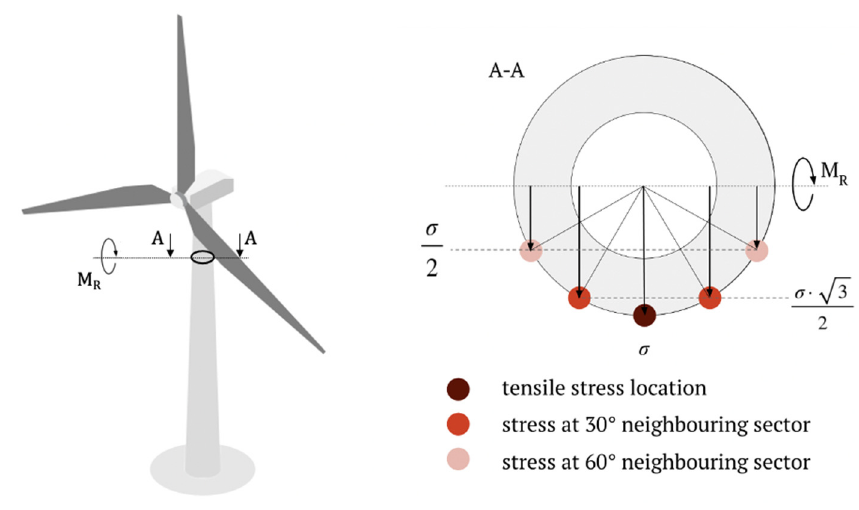
Figure 5. Principle of stress interactions coming from neighboring sectors; left figure altered from original icongrams figure [44] .